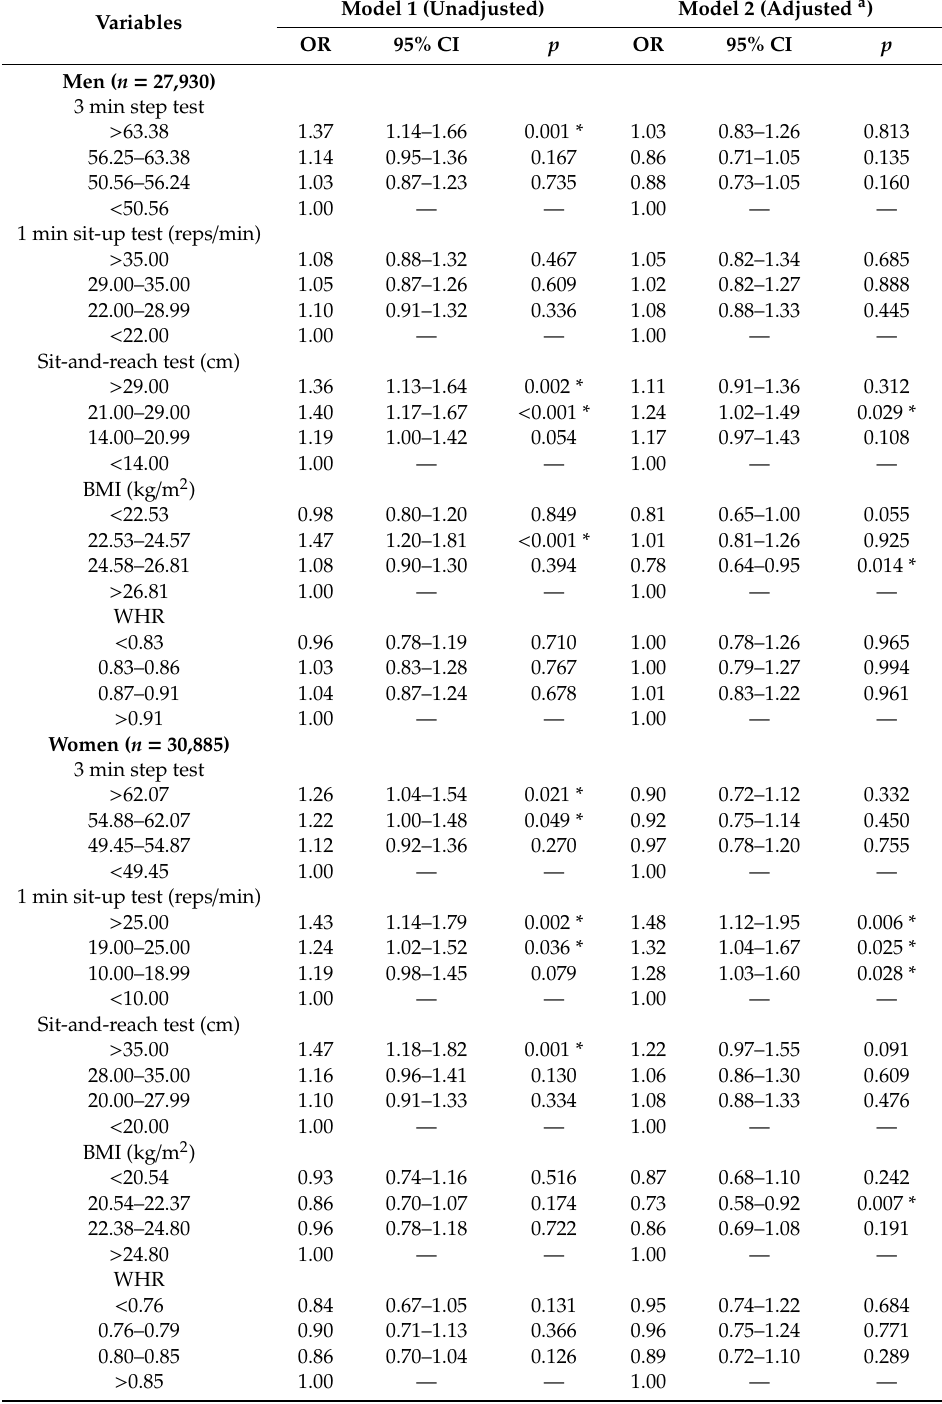
Table 4. Multivariate-adjusted ORs for the quartiles of happiness’ relations to health-related physical fitness measurements after adjustment for potential